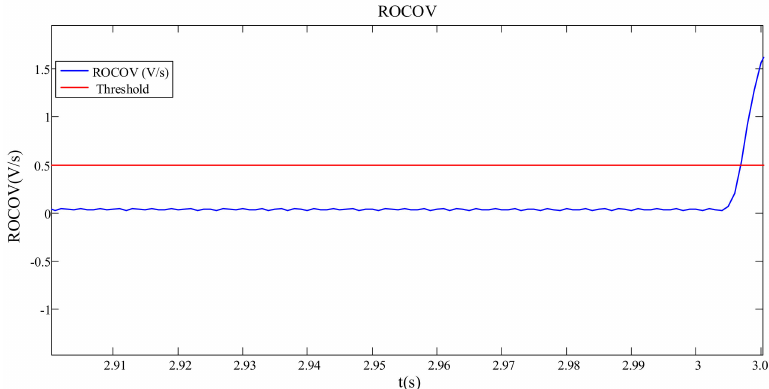
Figure 8. The output of ROCPAD relay in islanding mode with high power mismatch.